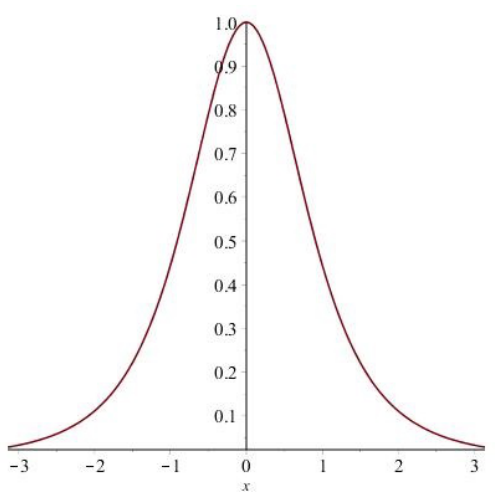
Figure 8. The scalar curvature R concerning the free energy fluctuations as a function of the vacuum parameter x : = θ , describing fluctuations of the YM vacuum ensemble for a given anomaly factor c with the critical exponent e =